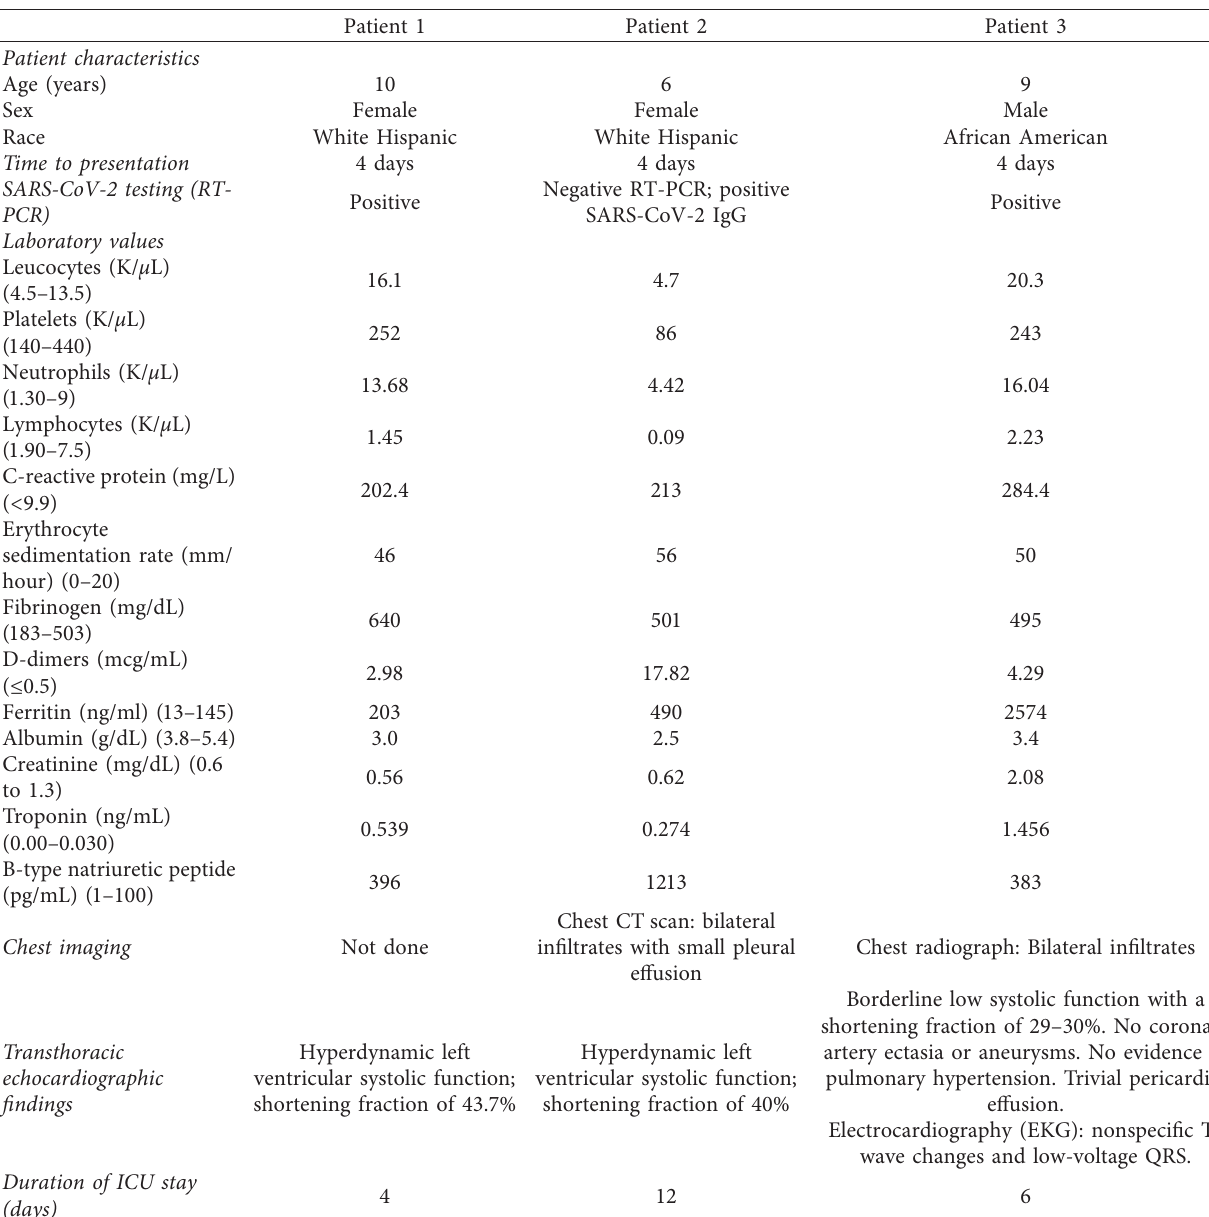
Table 1: Clinical characteristics of